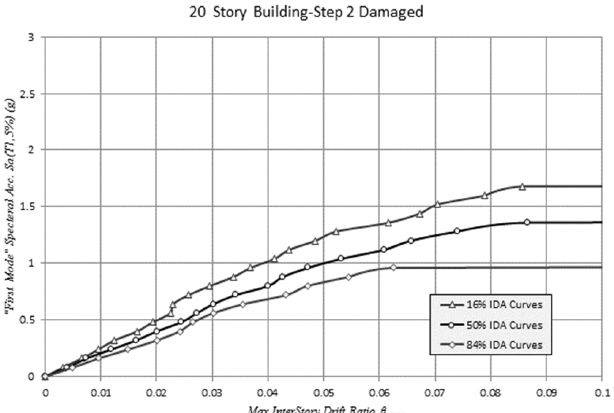
Figure 29. Curves of 16%, 50%, and 84% for IDA curves obtained for a slightly damaged 20-story frame (by removing one beam and one column on the tenth floor in addition to removing one beam and one column on the fifth floor).